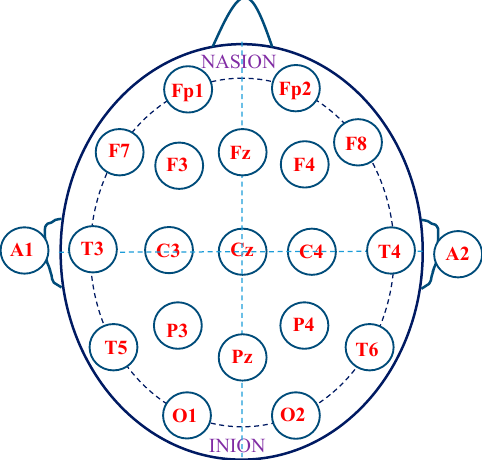
Figure 2. Top view of the international 10–20 electrode placement system on a human scalp.